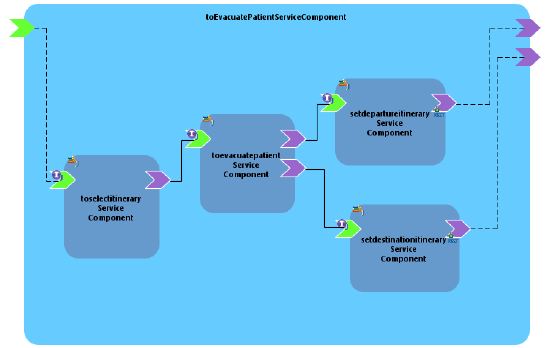
Figure 5. Context-aware Evacuation